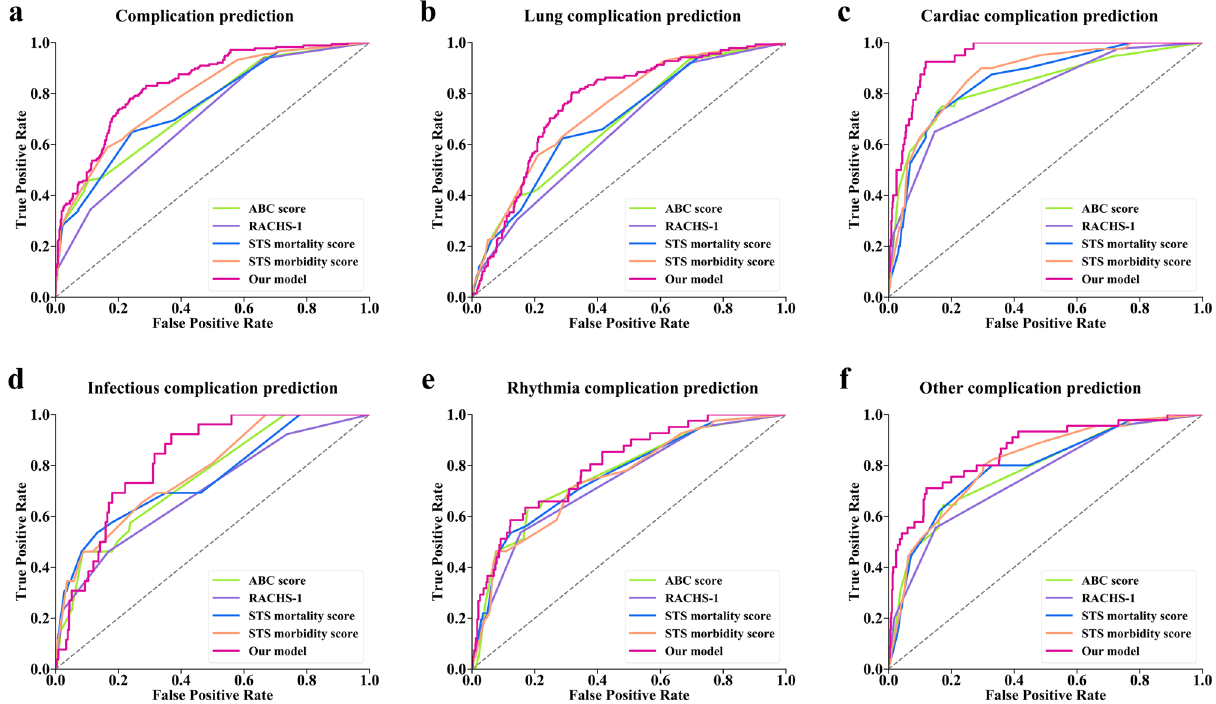
Figure 3. Receiver operating characteristic curve of the predictive models in the test data set. (a) Binary classification; (b–f) Multi-label classification. ABC Aristotle basic complexity, RACHS-1 risk adjustment for congenital heart surgery, STS Society of Thoracic Surgeons.